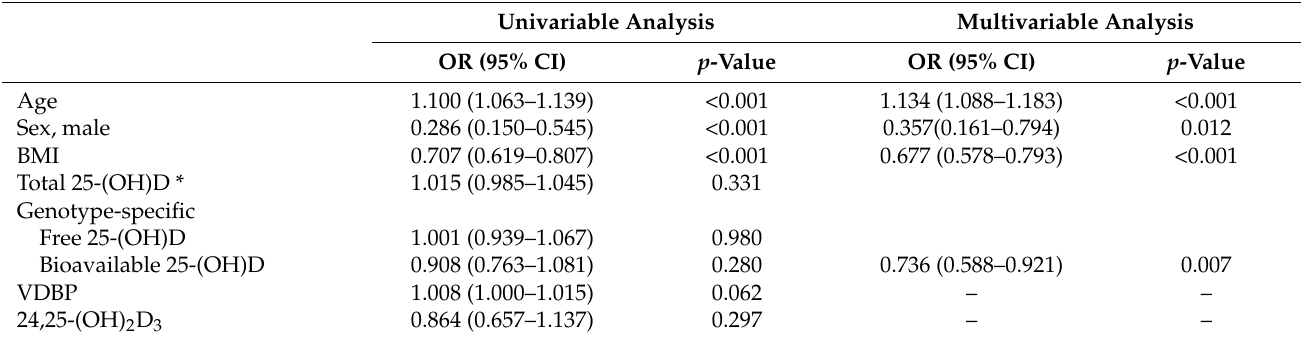
Table 4. Risk factors associated with NTM-PD among study